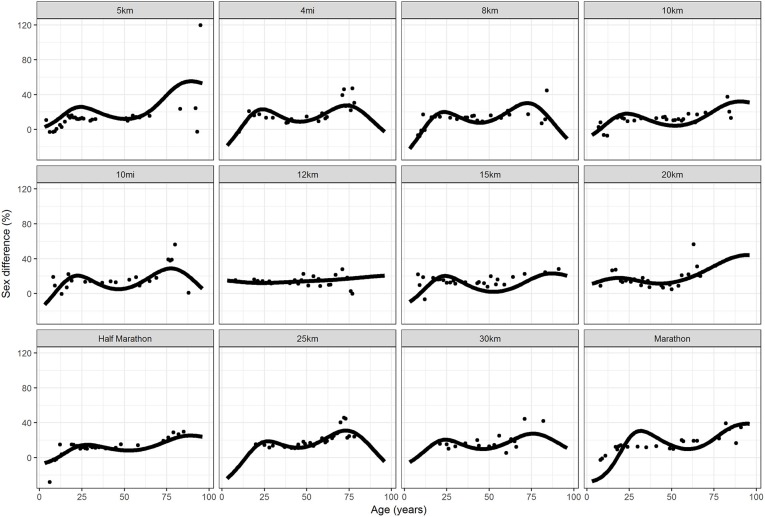
Sex differences by age (in years) from 5 km to marathon. Points were observations. Curves represented fitted values, with country being the reference group (USA).